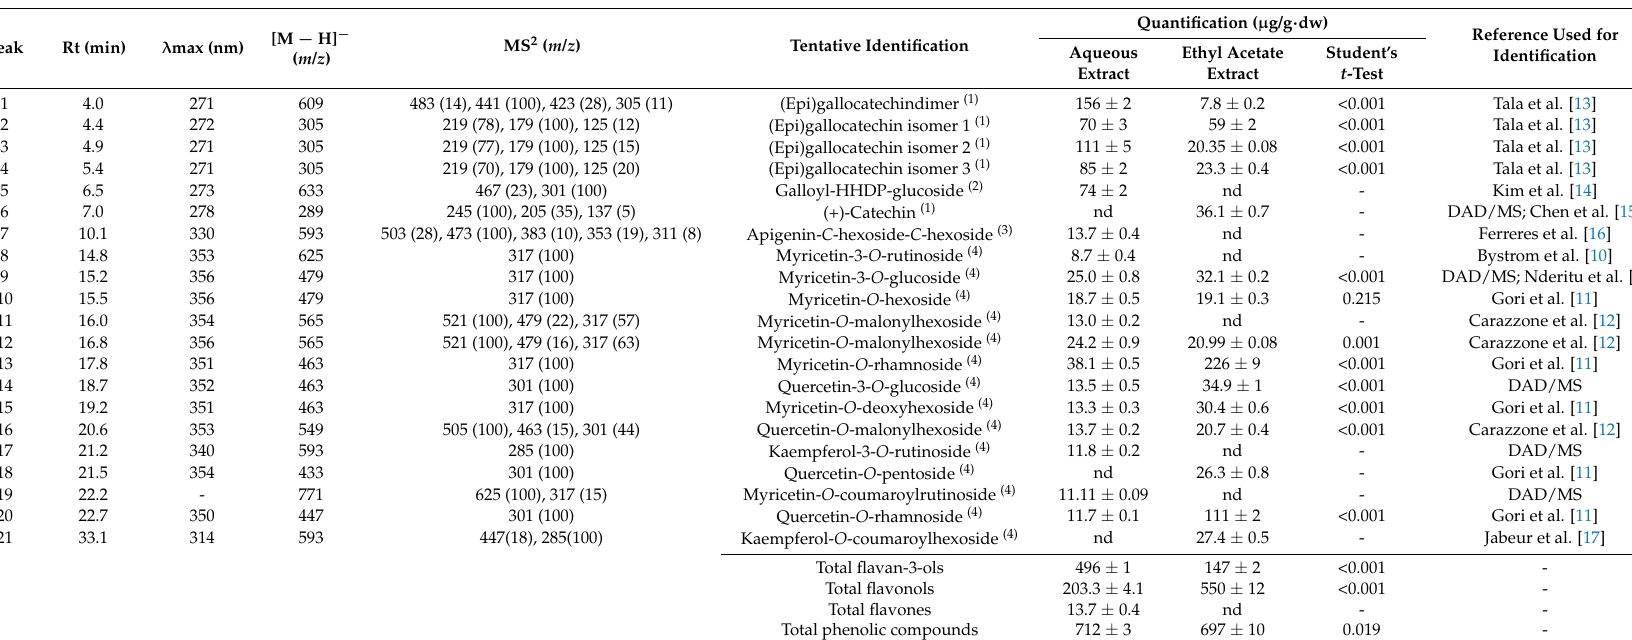
Table 1. Retention time (Rt), wavelengths of maximum absorption in the visible region ( λ max ), mass spectral data, identification and quantification of phenolic compounds in C. villosus extracts (mean ±